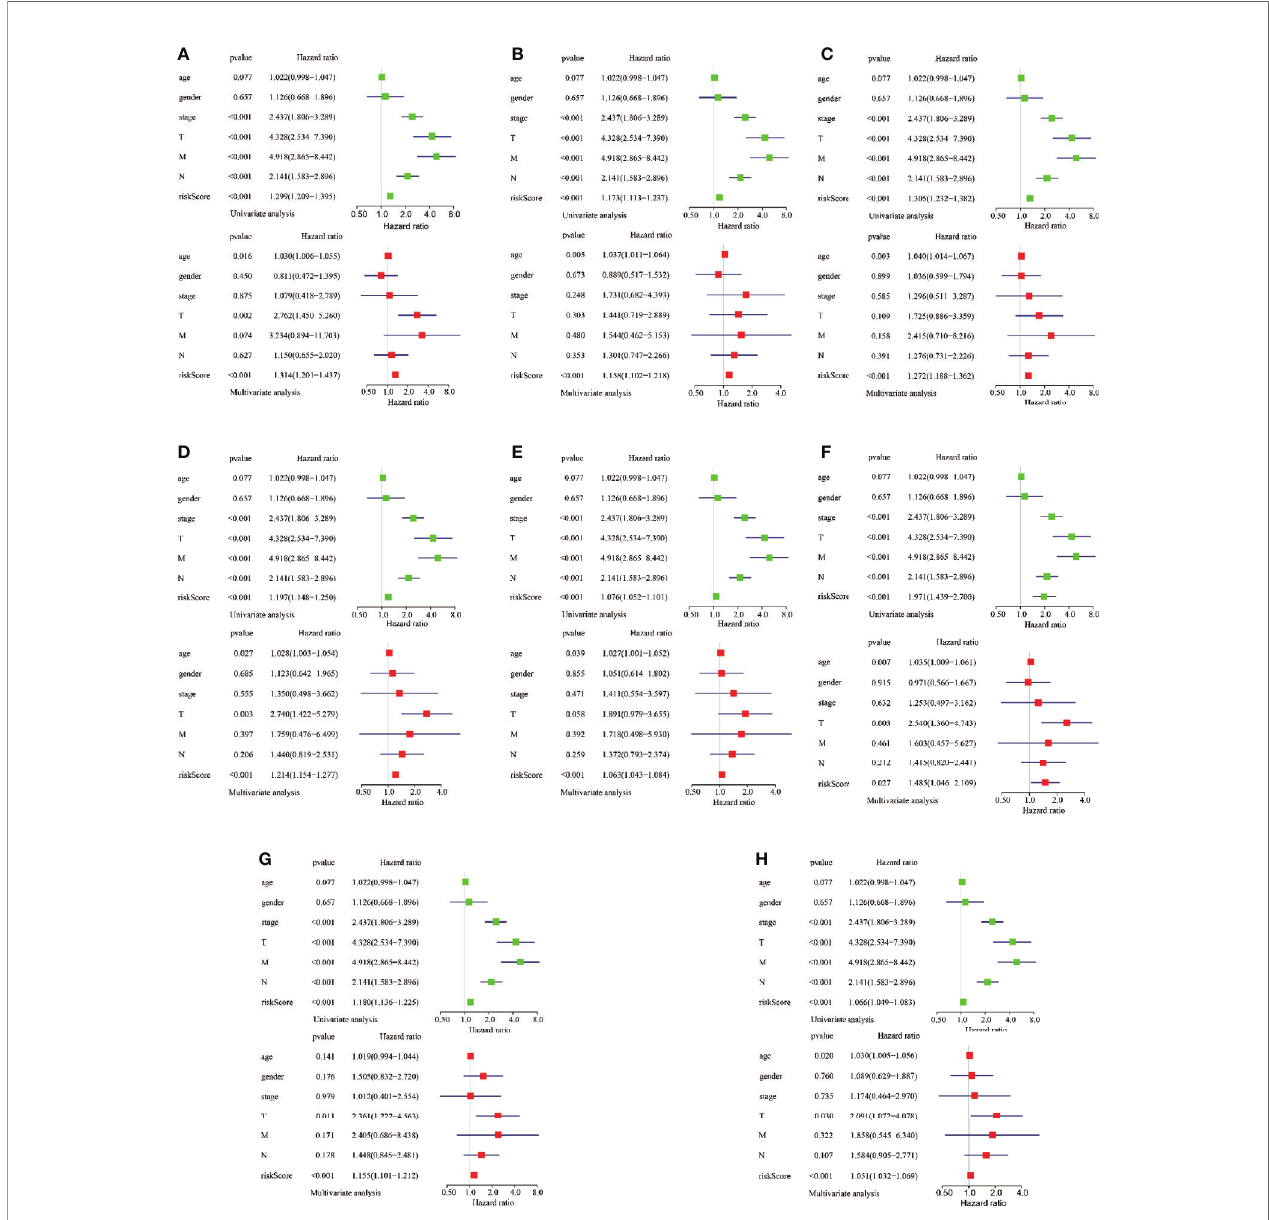
FIGURE 5 | Assessment of AS risk model in predicting CRC prognosis. (A – H) represents the AS events AA, AD, AP, AT, ES, ME, RI, and total events, respectively. Forest plot visualizing hazard ratios of signi fi cant survival-related clinical pathological parameters including age, gender, stage, and pathological stage T, M, and N obtained by univariate (top-green point) and multivariate (bottom-red point) Cox regression